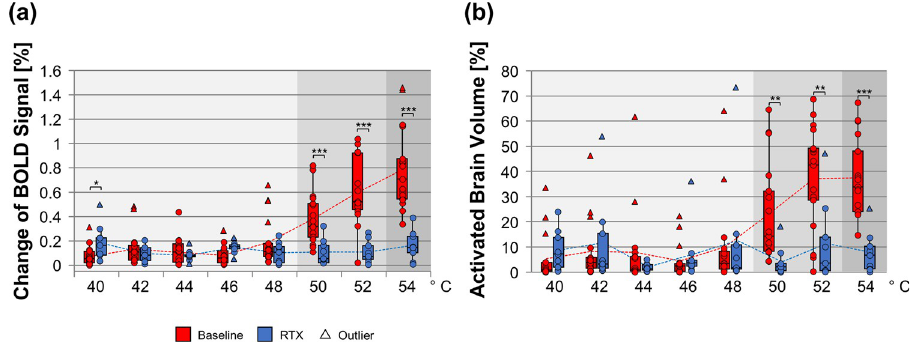
Fig 2. Whole brain BOLD response amplitude and activated brain volume evoked by different temperatures. Depicted are single animal values (dots) as well as mean (dotted lines) BOLD response amplitude (a) and activated volume (b) over all brain areas evoked by innocuous (light grey box), noxious (middle grey box) and highly noxious (dark grey box) temperatures for both groups. Whereas the untreated animals (baseline, red) showed increasing brain responses well correlated to the linear temperature increase (r Amplitude = 0.89, r Volume = 0.88; also see S1 Fig, correlation coefficient), RTX-treated rats (blue) failed to show increased responses to temperatures between 48˚C and 52˚C (r Amplitude = -0.04, r Volume = 0.03). With 54˚C, a slight but insignificant (p 52vs54˚C = 0.067, paired Student’s t-test) increase could be noted for the response amplitude. Activated brain volume is represented as percentage of total brain volume per animal. Statistical significance between groups was calculated using homoscedastic Student’s t-test and corrected for multiple comparisons by FDR q = 0.05. Boxplots span the 25% to the 75% quartile (median included). A horizontal line marks the median. The whiskers represent minimum and maximum values. Values below 1.5 times the interquartile range from minimum and above 1.5 times the interquartile range from maximum are considered as outliers (triangles). Means of each group are connected by a dotted line. � p � 0.05; �� p � 0.01; ��� p � 0.001. (n Baseline = 18; n RTX =